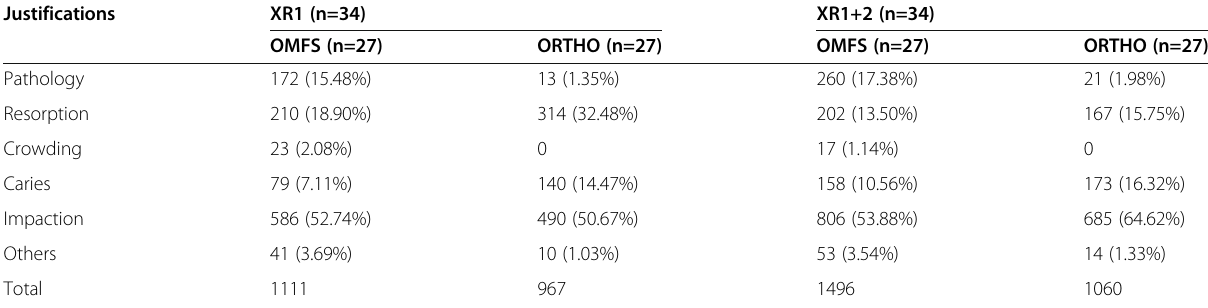
Table 5 Frequency of the justifications for the extraction of the lower third molars when orthodontists (ORTHO) and oralmaxillofacial surgeons (OMFS) examined one (XR1) or two serial (XR1+2)